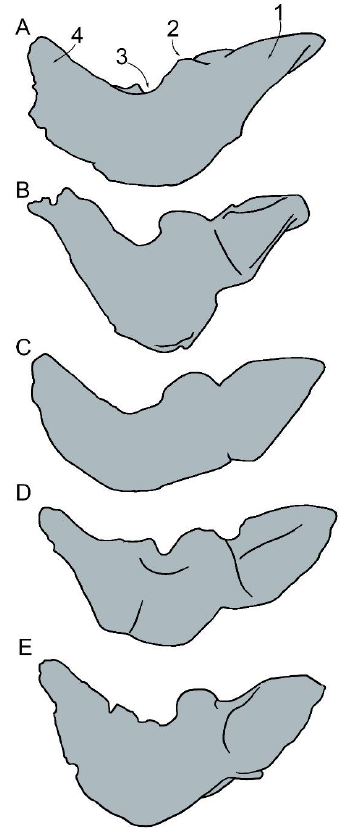
Figure 17. Morphology of eurhinodelphinid periotics in dorsal view showing selected characters used in phylogenetic analysis and comparisons. Caption: 1, size of anterior process; 2, size and shape of lateral tuberosity; 3, width of epitympanic hiatus; 4, size and shape of posterior process. Not to scale. ( A ) Eurhinodelphis longirostris . ( B ) Eurhinodelphis cocheteuxi . ( C ) Ziphiodelphis abeli . ( D ) Xiphi- acetus cristatus . ( E ) Ziphiodelphis sigmoideus (MGPT-PU 13881/2). In the lateral view, the resemblance of the squamosal of MGPT-PU 13881/1-2 and that of Ziphiodelphis sigmoideus is observed. Detailed photographic plates showing the squa- mosal of Ziphiodelphis sigmoideus were published in ref. [9]. The anterodorsal portion of the zygomatic process of the squamosal in this species is characterized by an inflated and globular part that makes contact with the postorbital process of the frontal (see also Figure 18). The anteroventral portion is characterized by an articular facet squared in the lateral view, which serves the articulation with the jugal bone. Taken together, these two struc- tures provide the anterior border of the zygomatic process of the squamosal of Ziphiodel- phis sigmoideus, a squared anterior outline, and a robust appearance. The same outline is matched by the zygomatic process of the squamosal of MGPT-PU 13881/1-2.